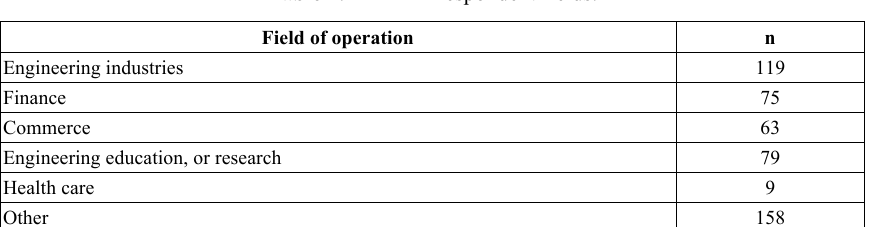
Respondent fields.